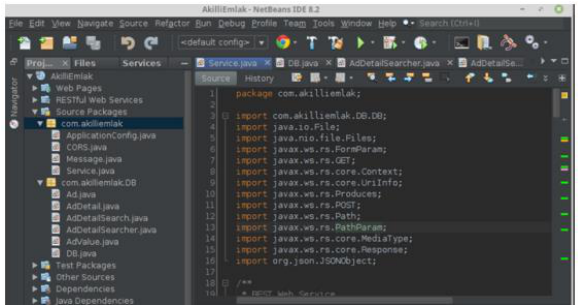
Figure 3. Screenshot of the Netbeans development